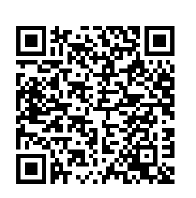
Figure 2. QR code to download the aug- mented reality